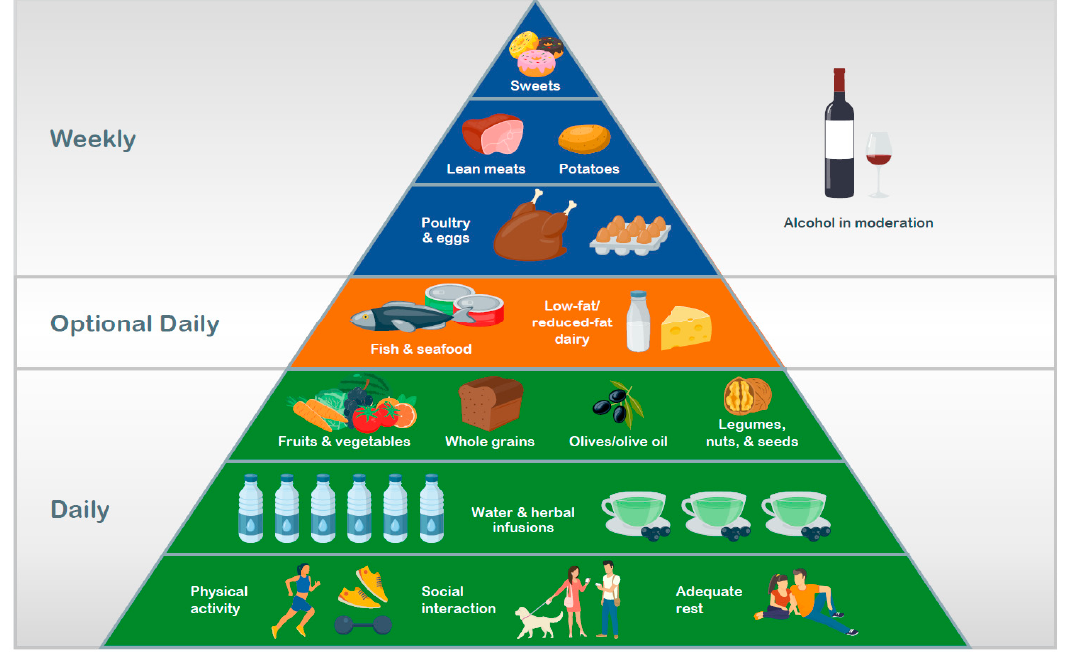
Figure 1. A generalized healthy diet and lifestyle pyramid.